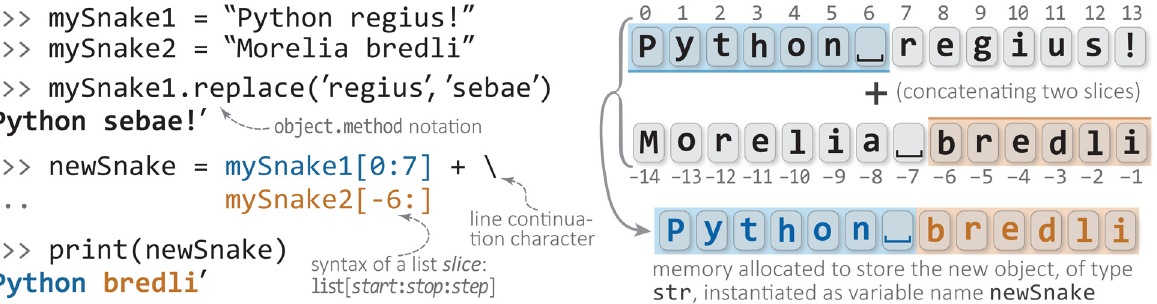
Fig 1. Strings in Python: anatomy and basic behavior. The anatomy and basic behavior of Python strings are shown, as samples of actual code (left panel) and corresponding conceptual diagrams (right panel). The Python interpreter prompts for user input on lines beginning with >>> (leftmost edge), while a starting ... denotes a continuation of the previous line; output lines are not prefixed by an initial character (e.g., the fourth line in this example). Strings are simply character array objects (of type str ), and a sample string- specific method ( replace ) is shown on line 3. As with ordinary lists, strings can be ‘ sliced ’ using the syntax shown here: the first list element to be included in the slice is indexed by start , and the last included element is at stop-1 , with an optional stride of size step (defaults to one). Concatenation, via the + operator, is the joining of whole strings or subsets of strings that are generated via slicing (as in this case). For clarity, the integer indices of the string positions are shown only in the forward (left to right) direction for mySnake1 and in the reverse direction for mySnake2 . These two strings are sliced and concatenated to yield the object newSnake ; note that slicing mySnake1 as [0:7] and not [0:6] means that a whitespace char is included between the two words in the resultant newSnake , thus obviating the need for further manipulations to insert whitespace (e.g., concatenations of the form word1+' '+word2